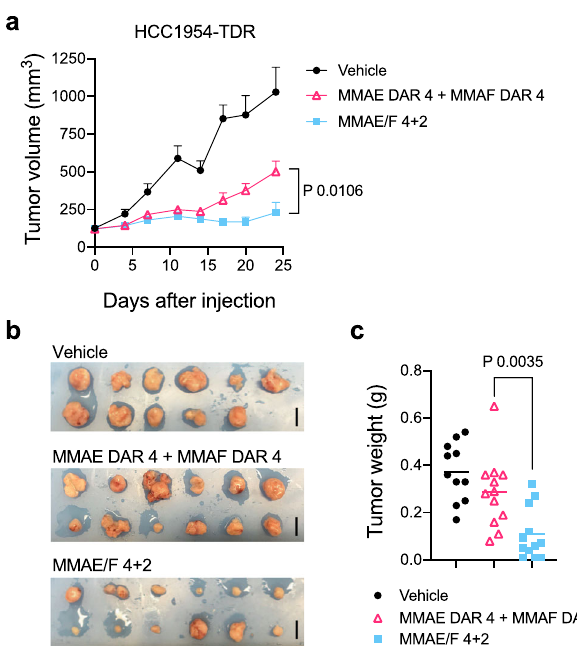
Fig. 6 In vivo antitumor activity in the low-HER2 heterogeneous HCC1954-TDR model. a Antitumor activity of each ADC in the HCC1954- TDR orthotopic breast tumor model (female NU/J mice, n = 11 for vehicle; n = 12 for other groups). Once tumors reached an average volume of 125 mm 3 (indicated as day 0), mice were administered with a single dose of a 1 : 1 mixture of MMAF DAR 4 and MMAE DAR 4 ADCs (magenta open triangle, 1 mg kg − 1 each), MMAE/F 4 + 2 ADC (cyan square, 1 mg kg − 1 ), or vehicle control (black circle). All animals were killed 24 days post ADC injection. Data are presented as mean values ± SEM. b Tumors collected 24 days post injection of each ADC. Scale bar: 1 cm. c Weight of the collected tumors at Day 24. Lines represent mean values. For statistical analysis, a two-tailed Welch ’ s t -test was used. Source data are available as a Source Data fi